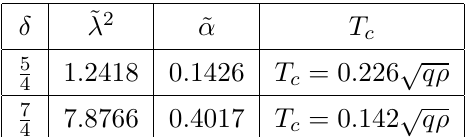
Table 1. Critical temperature for different scaling dimension for m 2 = − 3